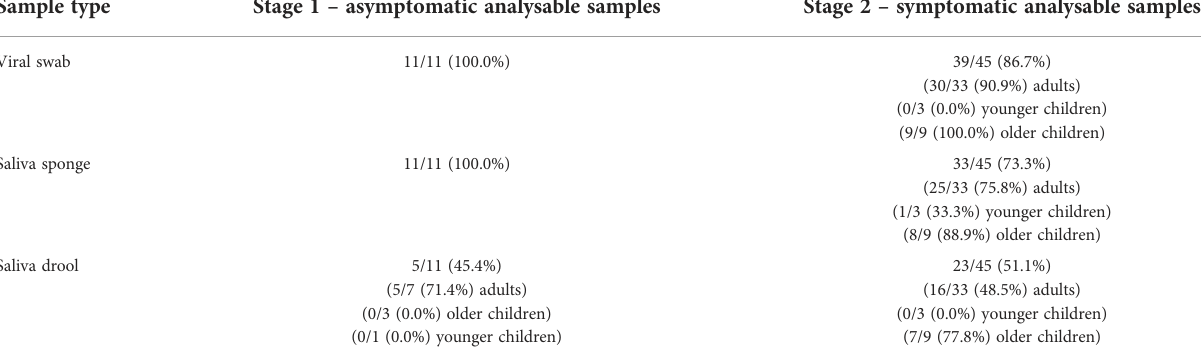
TABLE 5 Proportion of samples received by laboratory with suf fi cient volume for biomarker analysis by sample type. Sample